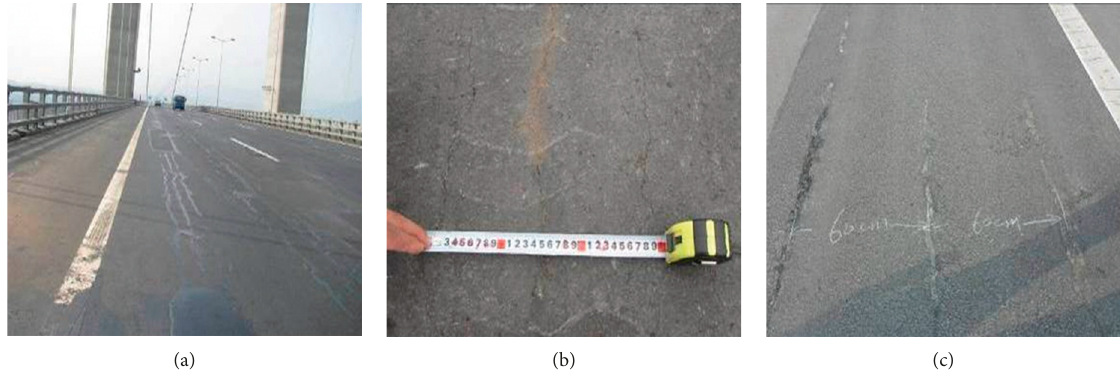
Figure 1: Fatigue cracks in epoxy asphalt on steel bridge deck pavement. Table 1: The aggregate gradation used in this